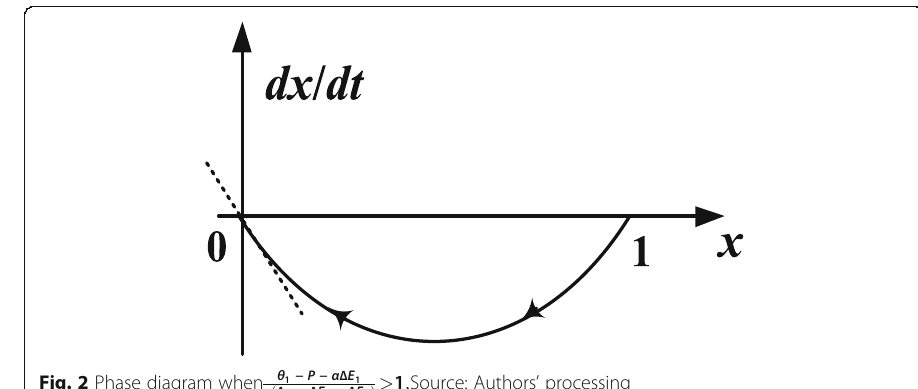
< 0 ; Source: Authors ’ ð Δ π − Δ E 1 − Δ E 2 Þ